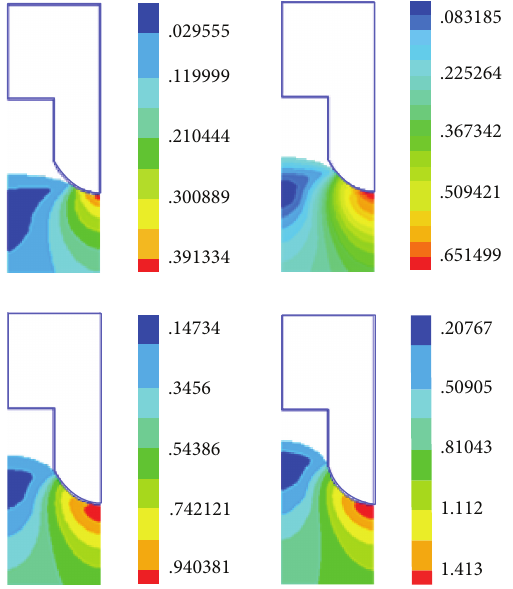
Figure 2: Specifications of the model and boundary conditions.